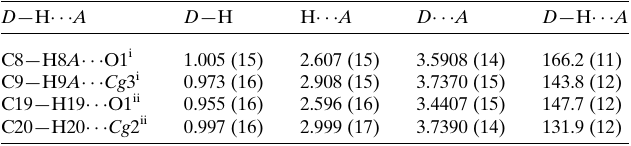
Table 2 Experimental details. Crystal data Chemical formula